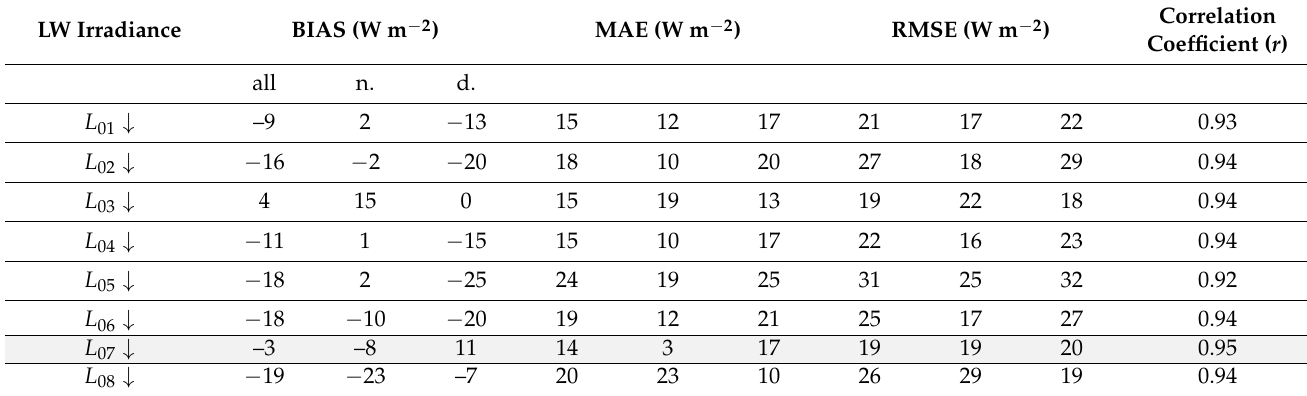
Table 12. Statistical errors and coefficients of correlation for clear sky conditions. (all—all cases, n.—nighttime and d.—daytime). Notations are similar to Table 10. (The best model is shaded). LW